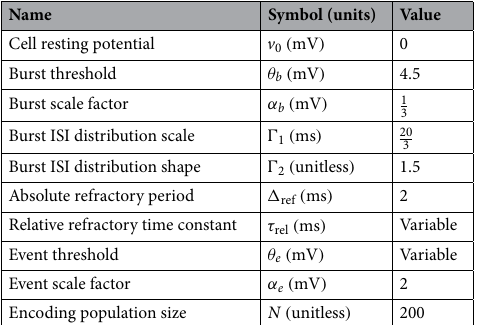
Table 2. Model parameters for the encoding